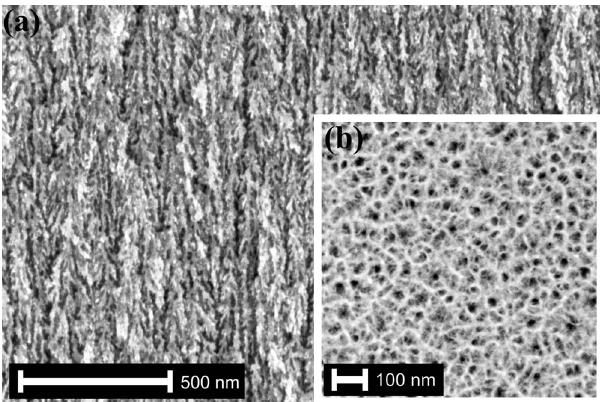
Fig. 6 Scanning electron microscope images of nanoporous silicon. a Side view: Cut through the membrane perpendicular to the surface. Dendritically grown pores parallel to [001] branching in small sub-pores with dead ends. b Top view: cut through the membrane parallel to the surface. Randomly distributed pores in (001).